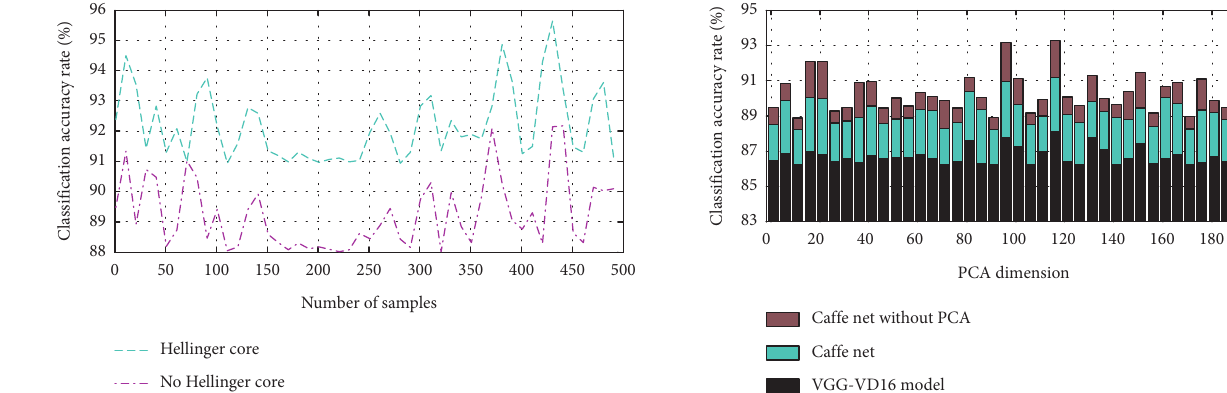
Figure 8: The impact of PCA transformation on “middle feature level aggregation.”